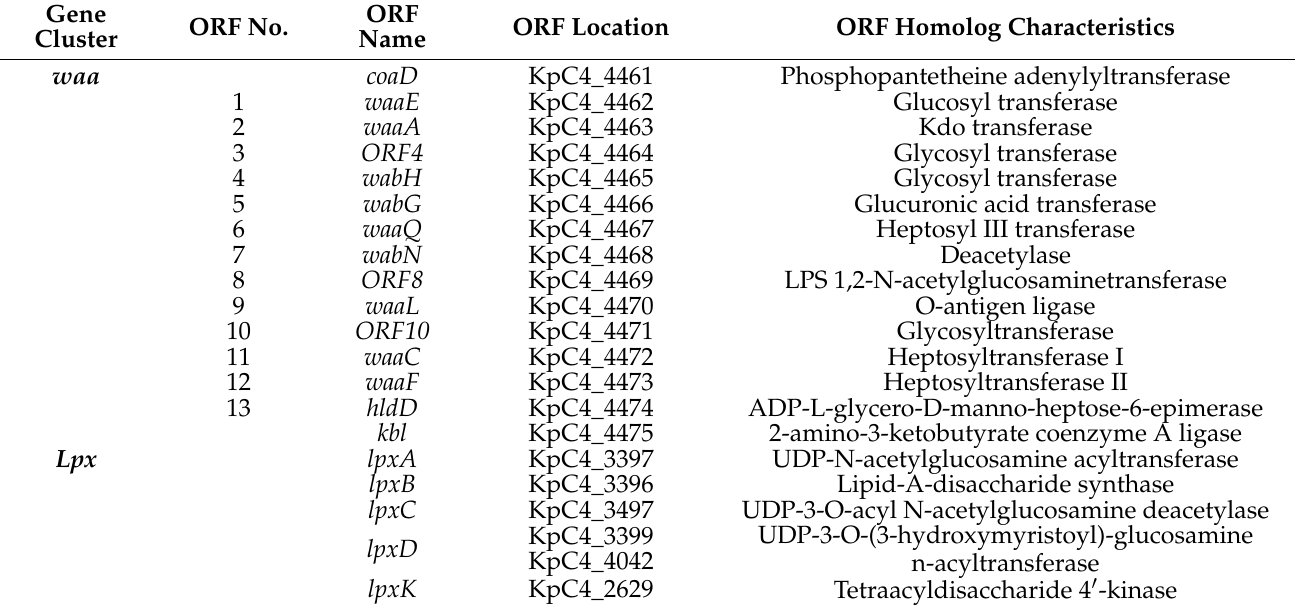
Table 3. Annotation of open reading frames (ORFs) of lipopolysaccharide biosynthesis (lps) loci in